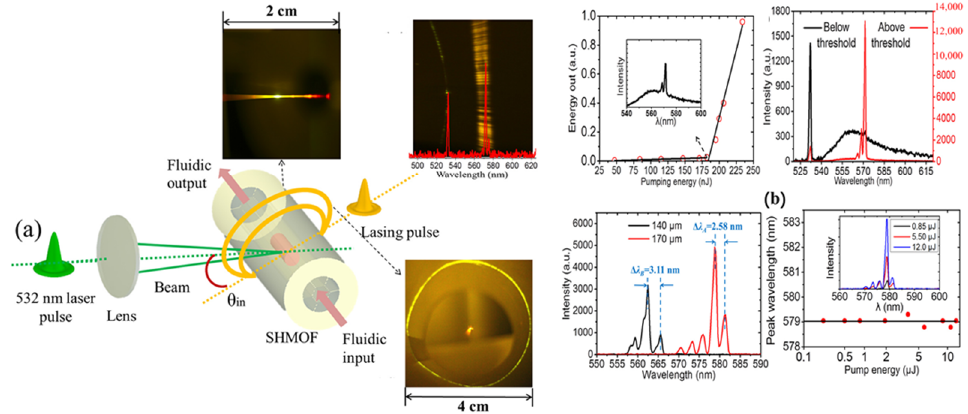
Figure 9. Schematic Diagram of Organic Dye Gain Microcavity Laser. ( a ) Layout of laser experimental system and ( b ) Output laser spectrum and resolution spectrum [66].